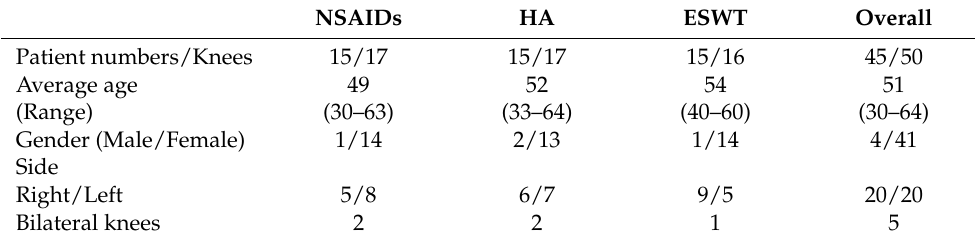
Table 1. Demographic data of patients of three